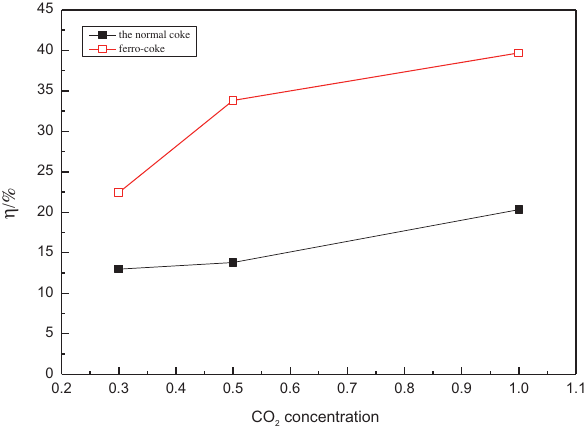
Figure 6: Comparison of weight loss ratio of normal coke and ferro- coke under various